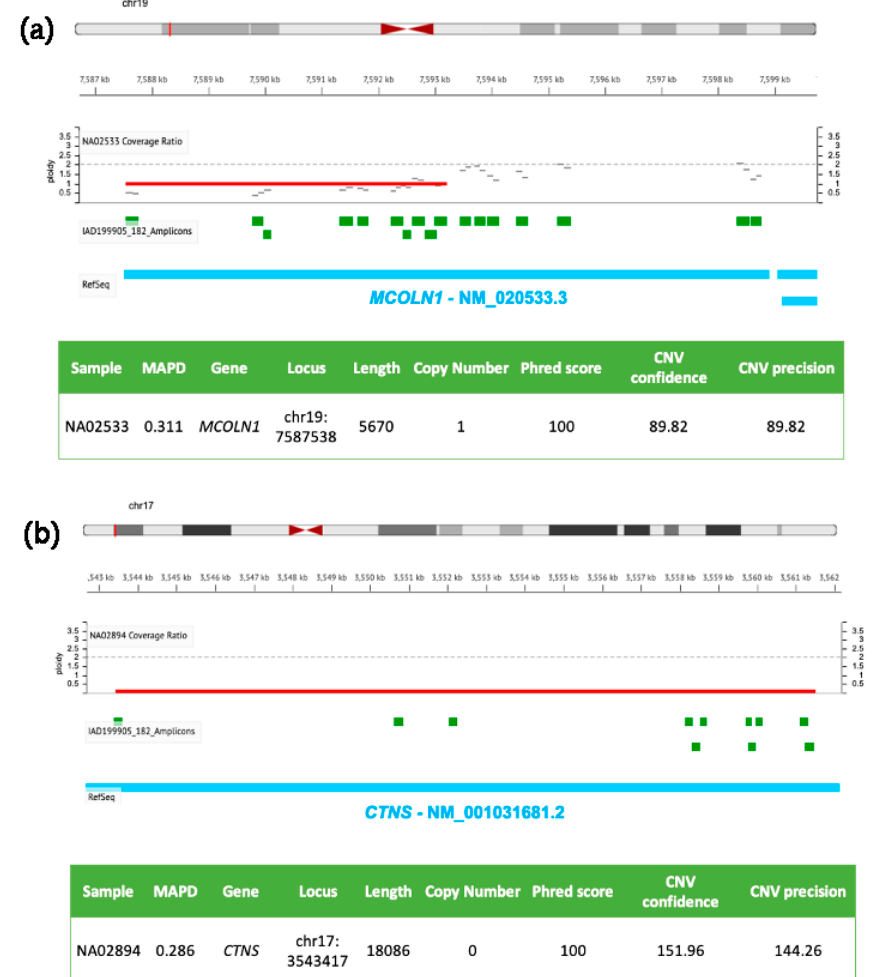
Figure 1. Molecular details of CNVs detected in MCOLN1 and CTNS by NGS. DNA samples (NA02533 in ( a ) and NA02894 in ( b )) were isolated from clinically diagnosed donor subjects obtained from the NIGMS Human Genetic Cell Repository at the Coriell Institute for Medical Research. Targeted NGS analysis was performed by using the tNGS panel previously described [126] and analyzed with the Ion Reporter Software (default parameters for germline CNVs, Median of the Absolute values of all Pairwise Differences < 0.4, CNV Confidence > 20, CNV precision > 10).